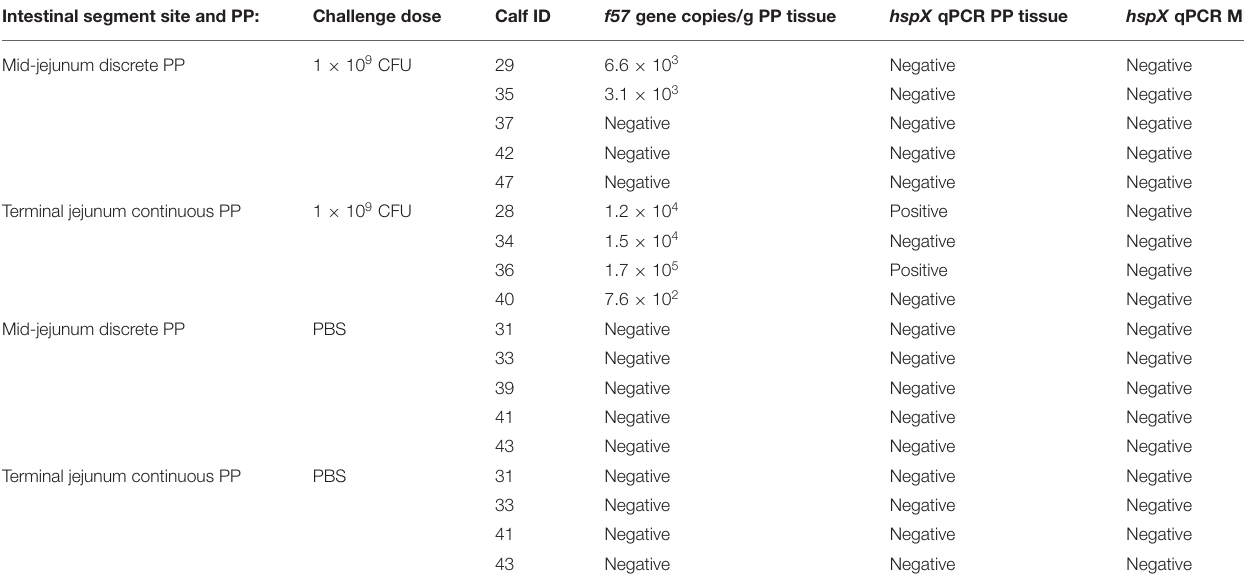
TABLE 1 | Summary of study animals and infection status at 12 months post-challenge. Intestinal segment site and